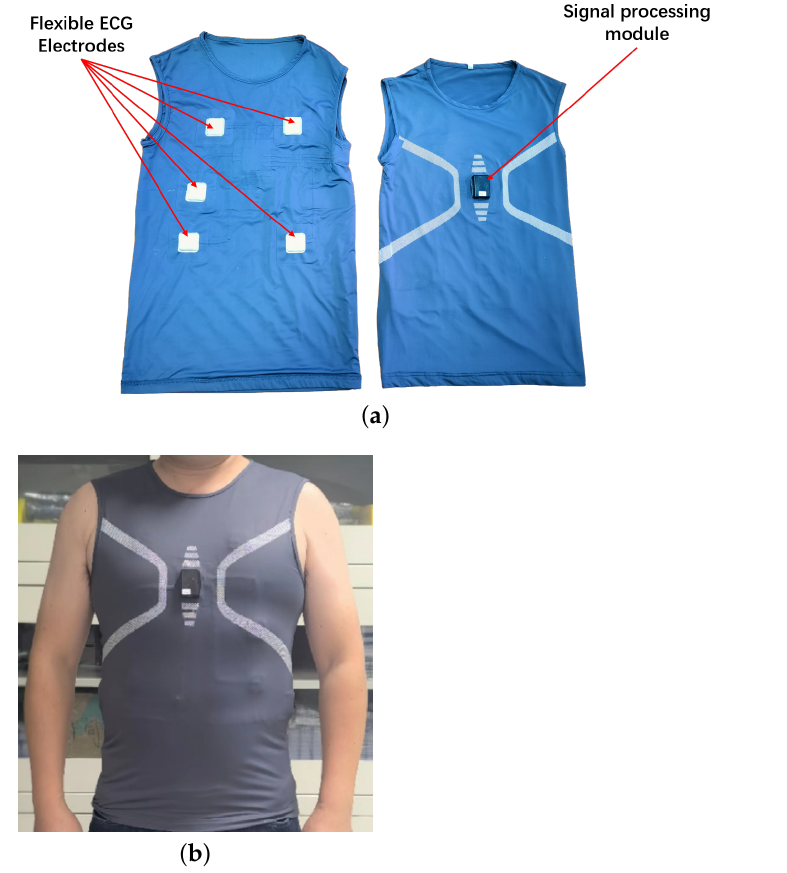
Figure 1. The smart ECG T-shirt. ( a ) The main modules of the smart ECG T-shirt. ( b ) A subject wearing the smart ECG T-shirt.